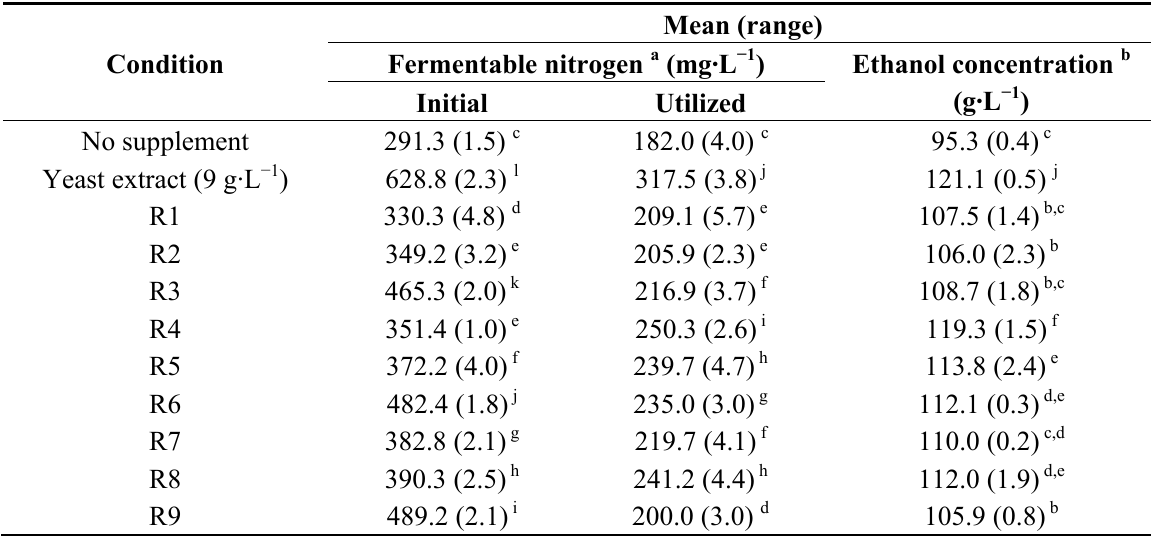
Table 6. Fermentable nitrogen during ethanol production from the synthetic medium under various nutrient supplements by S. cerevisiae NP